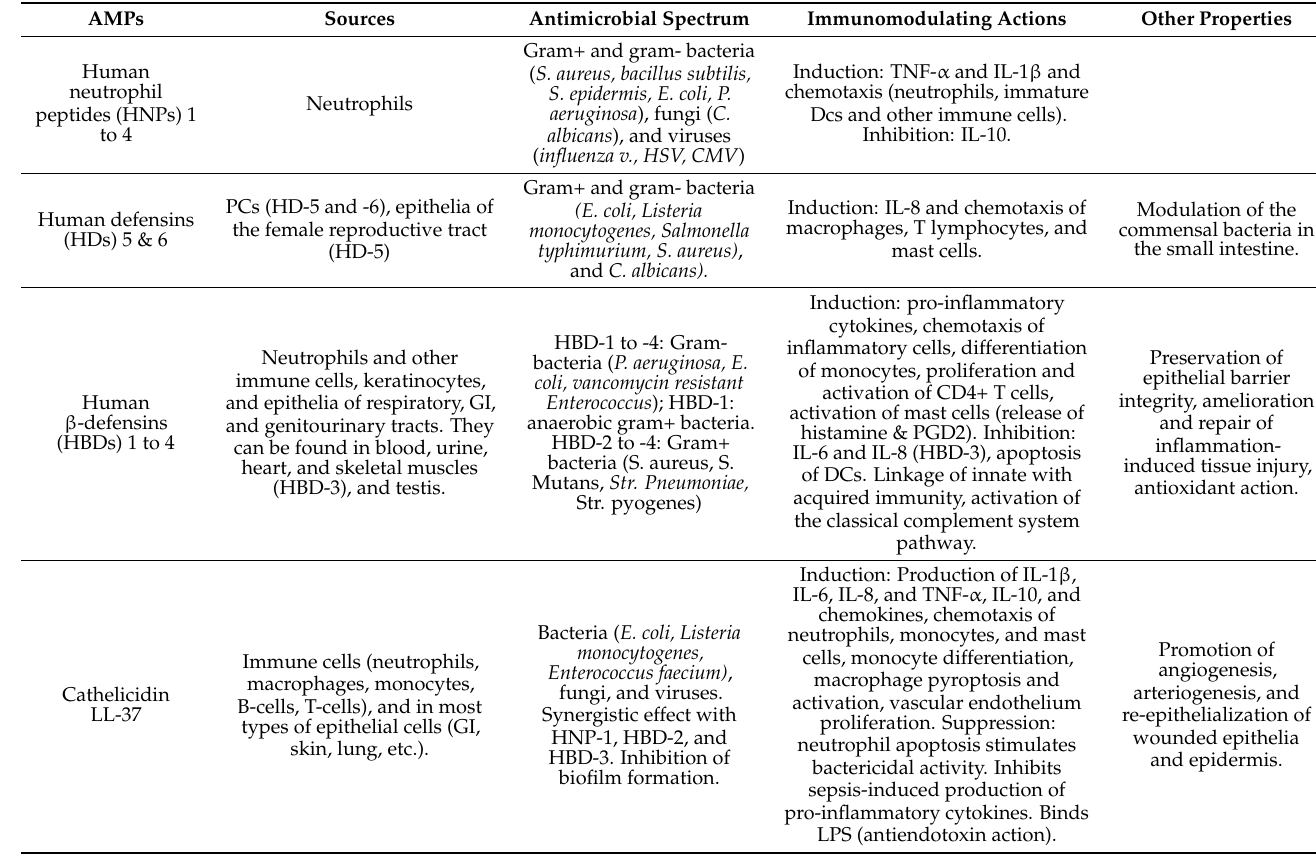
Table 1. Sources and properties of the main human antimicrobial peptides